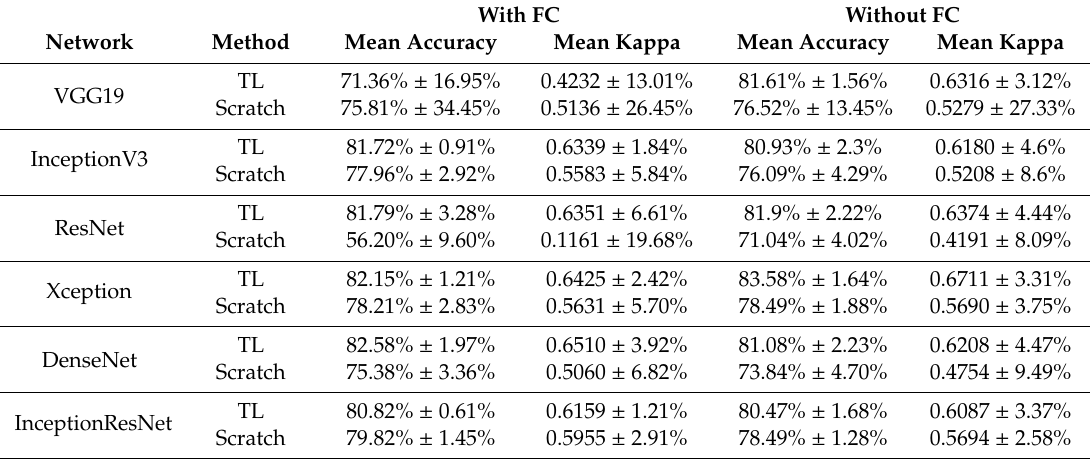
Table 6. Accuracy and Kappa scores of classifying elbow images with and without fully connected layers ( ± 95% CI).